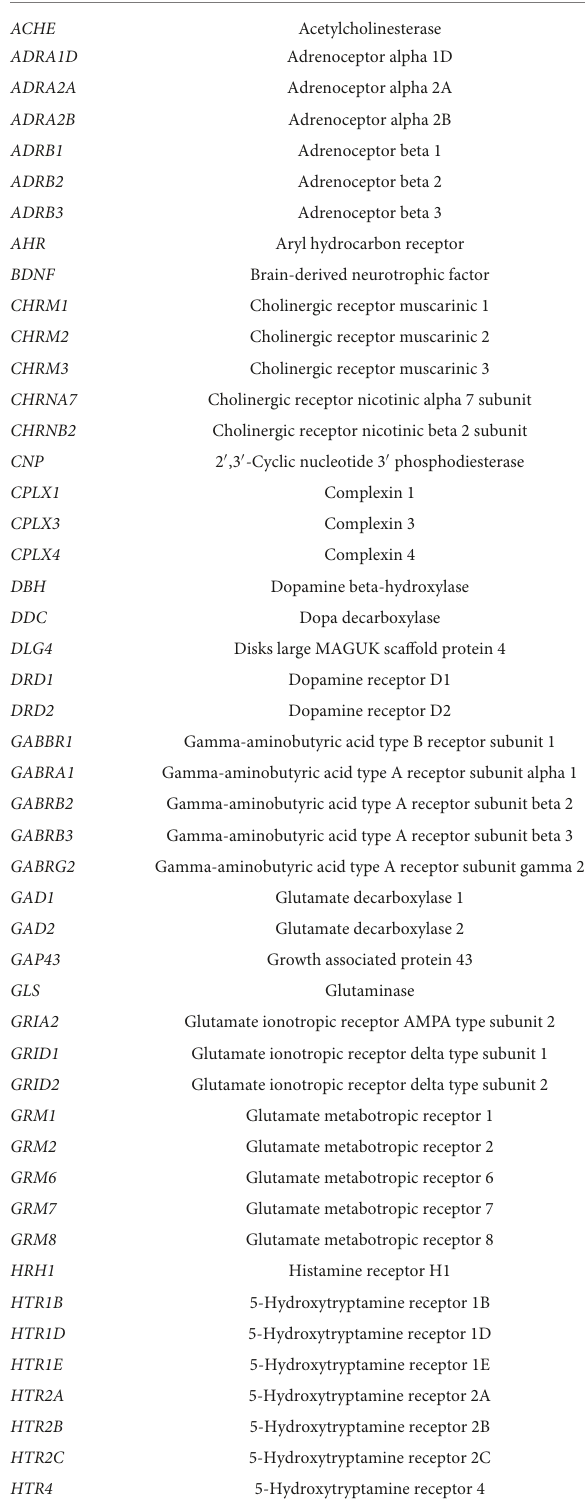
TABLE 1 Full NanoString list of genes associated with brain cellular processes and neurotransmission. Gene